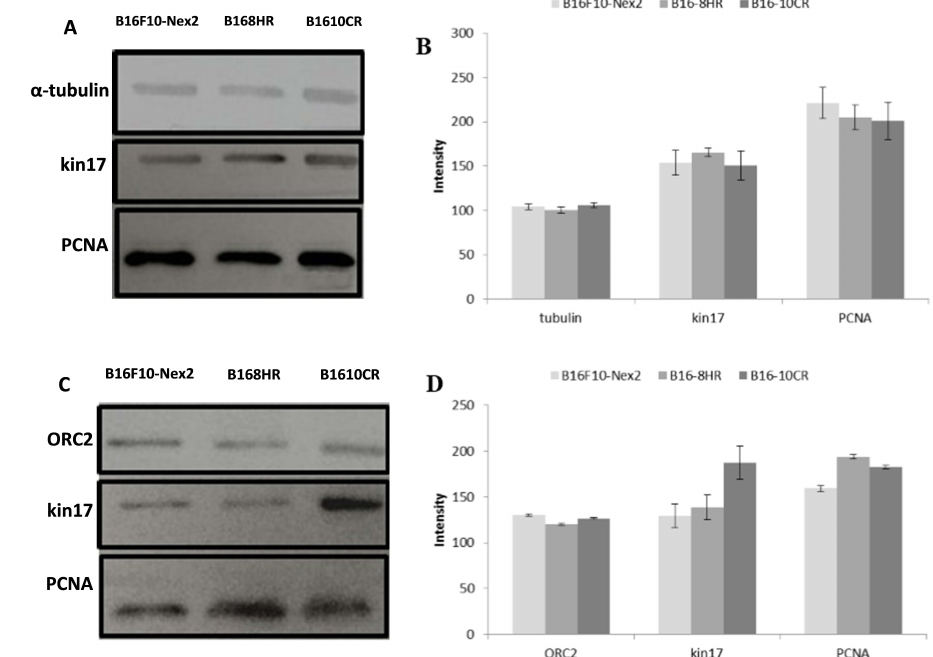
Figure 3. Kin17 protein detection by Western blotting in the nuclear compartments of the melanoma cell line B16F10-Nex2 clone B16-8HR and clone B16-10CR. ( A ) Expression of α -tubulin, kin17, and PCNA in nuclear protein fractions; ( B ) Densitometry measurements of α -tubulin, kin17, and